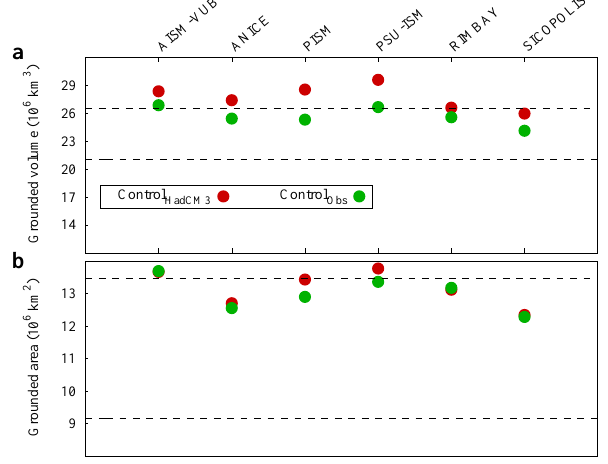
Figure 4. (a) Final grounded ice volume (10 6 km 3 ) and (b) fi- nal grounded ice area (10 6 km 2 ) for the control simulations with Bedmap1. Control HadCM3 in red, Control Obs in green. The horizon- tal dashed lines indicate the PD and Pliocene grounded ice volume and area of the initial ice-sheet